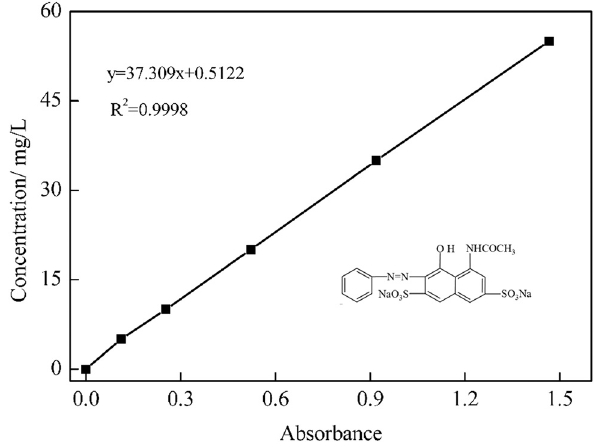
Figure 1: The standard curve of ARG dye concentration ( x ) versus absorbance ( y ) and its chemical